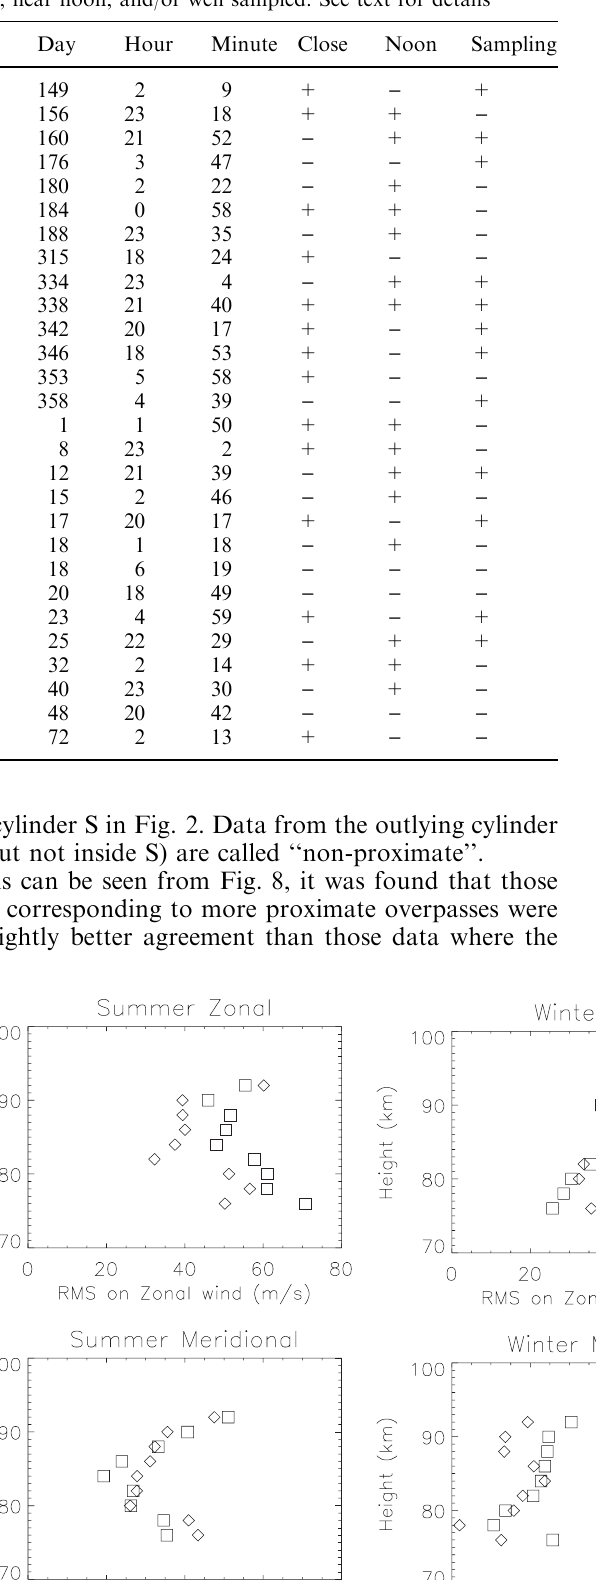
Table 1. HRDI overpasses, 1993–94. The date of each overpass is indicated, along with an indicator as to whether or not is ‘‘close’’ in space, near noon, and/or well sampled. See text for details